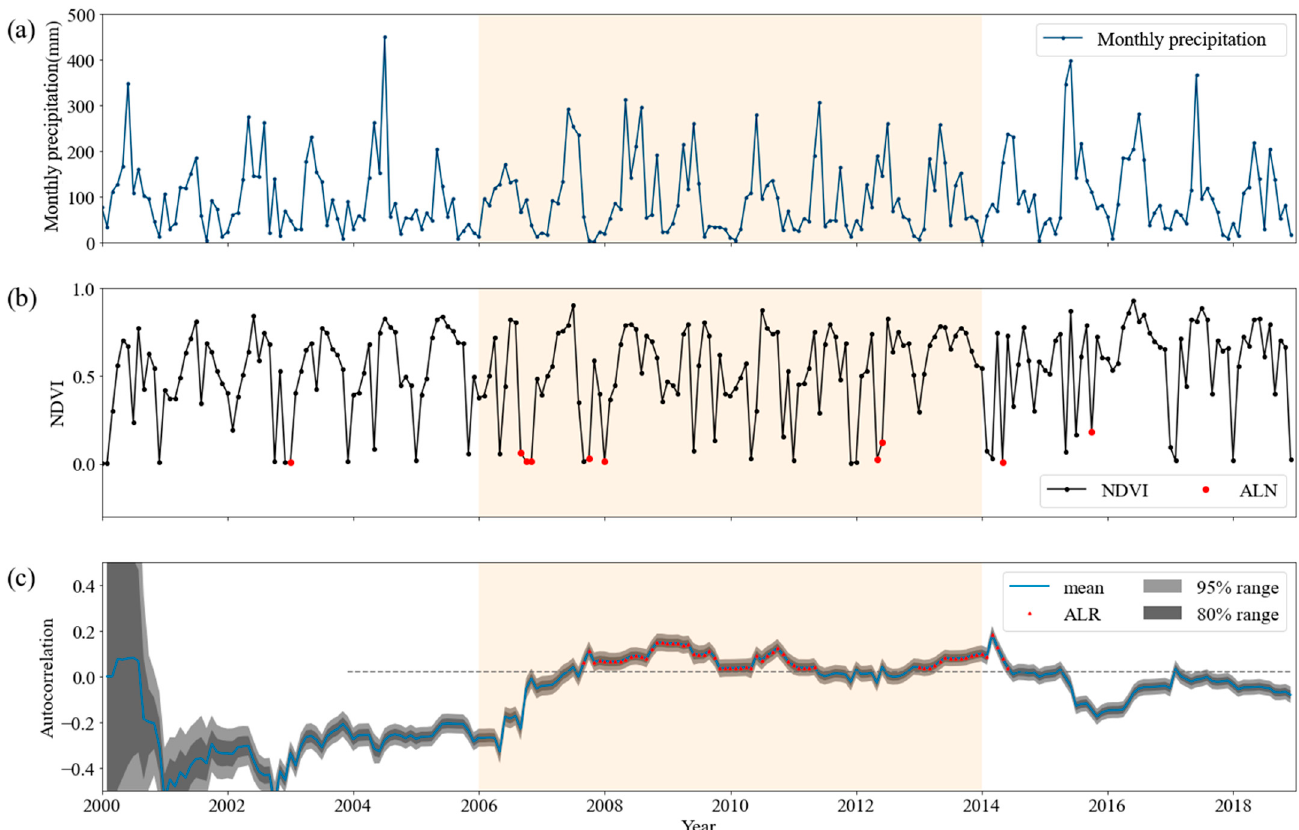
Figure 2. An example of ALR detected using the Bayesian dynamic linear model. ( a ) Time series changes of monthly precipitation at a pixel; ( b ) time series changes of NDVI at a pixel; ( c ) the time- variant autocorrelation and the ALR estimated by the BDLM at a pixel. The ALR were identified in the case of the mean autocorrelation (blue line) exceeding the threshold (grey dashed line) and the mean autocorrelation also exceeding zero. The threshold was defined as the long-term average of the upper bound of the indetermination range (not including a four-year prewarming period). The orange time range represents the droughts by the SPEI. Each tick on the x axis represents the January of each year.